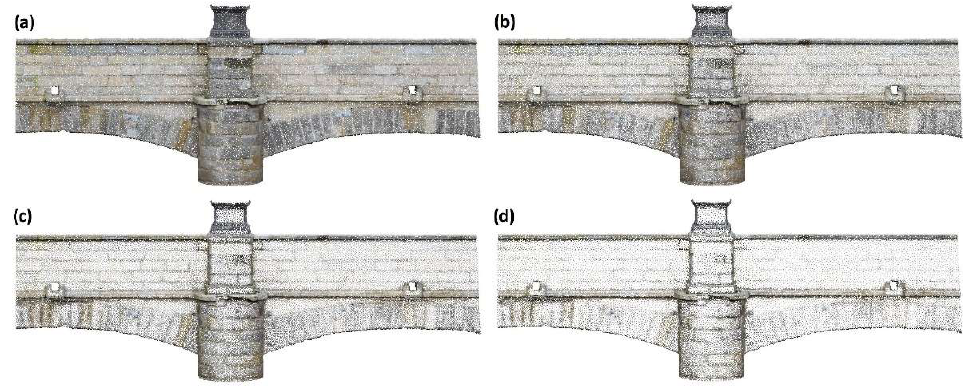
Figure 5. Examples of dilution: a = 0.02 m in all cases; ( a ) uniform dilution (i.e., b = 0.02 m); ( b ) b = 0.04 m; ( c ) b = 0.06 m; ( d ) b = 0.10 m.